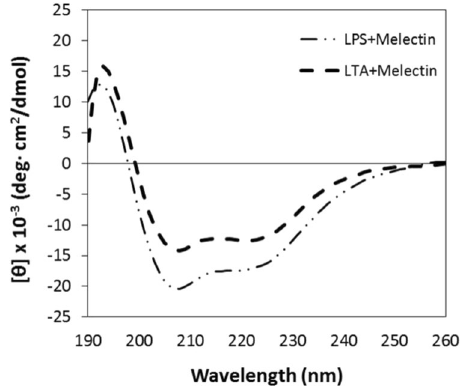
Figure 8. Interaction of melectin with LTA and LPS. Melectin was incubated with a 0.1% LTA aqueous suspension of S. aureus and a 0.1% LPS aqueous suspension of P. aeruginosa . The final concentration of the peptide was 40 μ M.